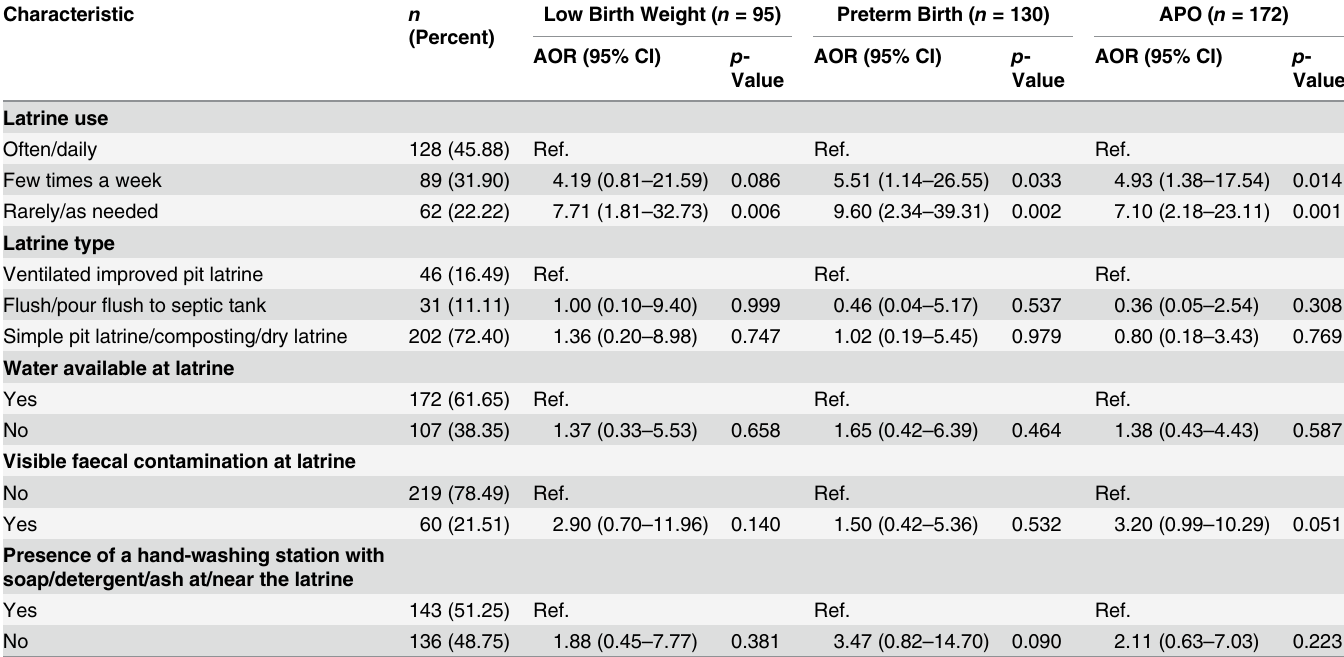
Table 4. Association between sanitation use and adverse pregnancy outcomes among participants with latrine access ( n = 279).